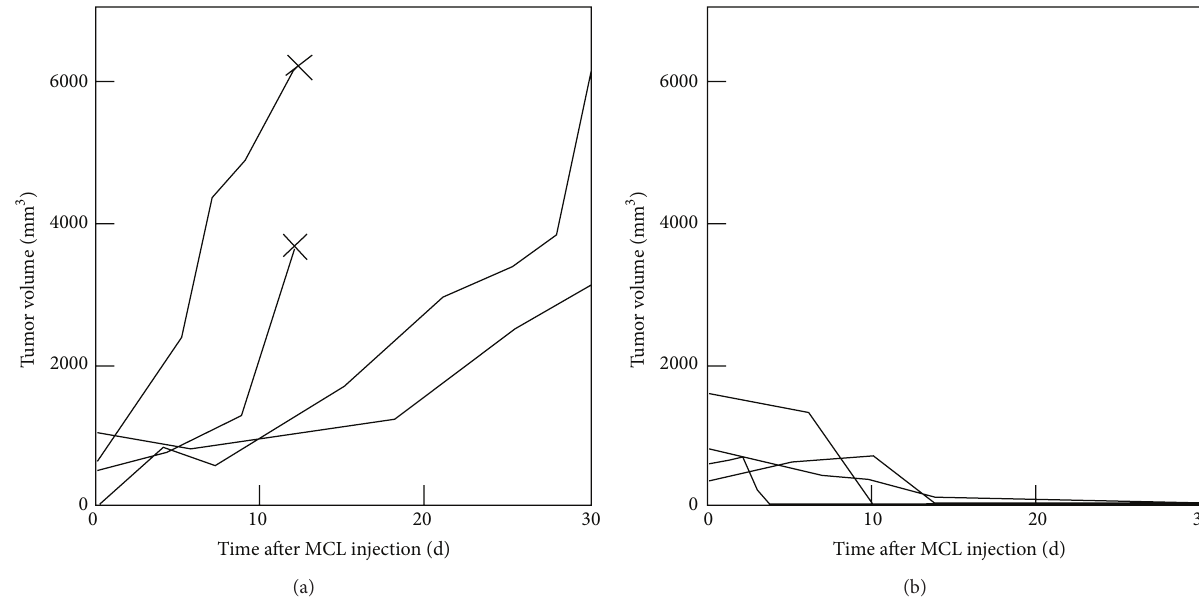
Figure 21: The effect of applying magnetic hyperthermia with magnetite particles in hamster samples after 30 days (120kHz AC magnetic field, 90 min per day). In case (a), without hyperthermia treatment, the tumors volume is increased while in case (b) the volume of treated tumors by hyperthermia is obviously decreased